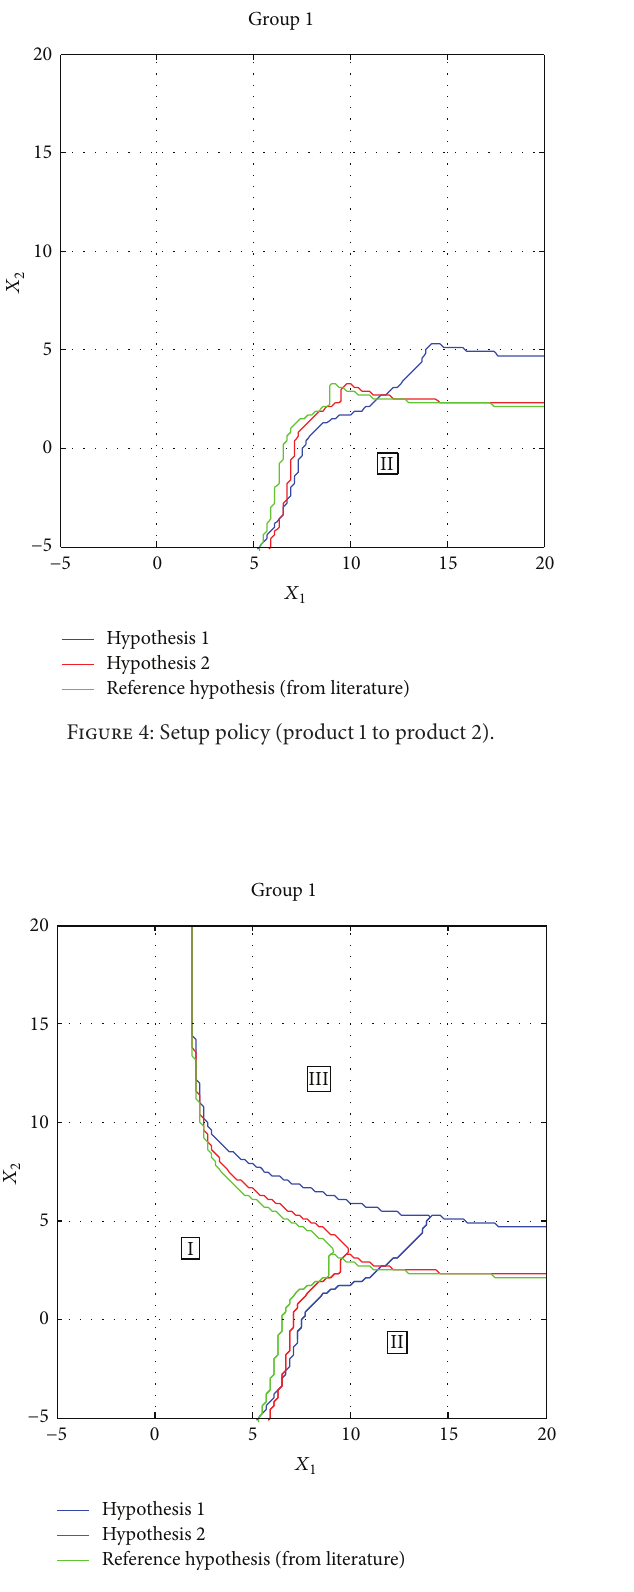
Figure 5: Production policy for 𝑃 1 and setup policy ( 𝑃 1 to 𝑃 2 ).